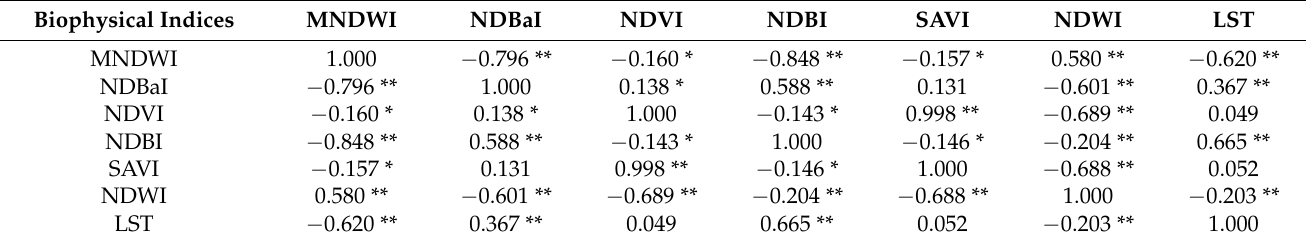
Table 4. Correlation between LST and the biophysical